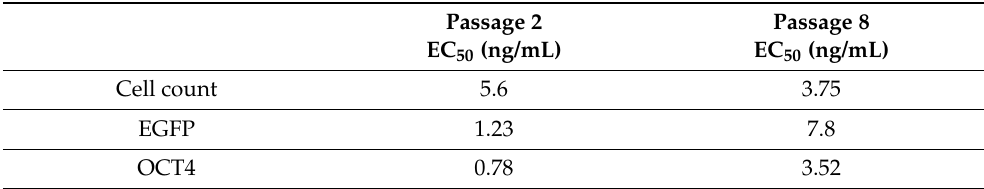
Table 1. Comparison of the calculated half-maximal effective concentration (EC 50 ) of BMP4 tested